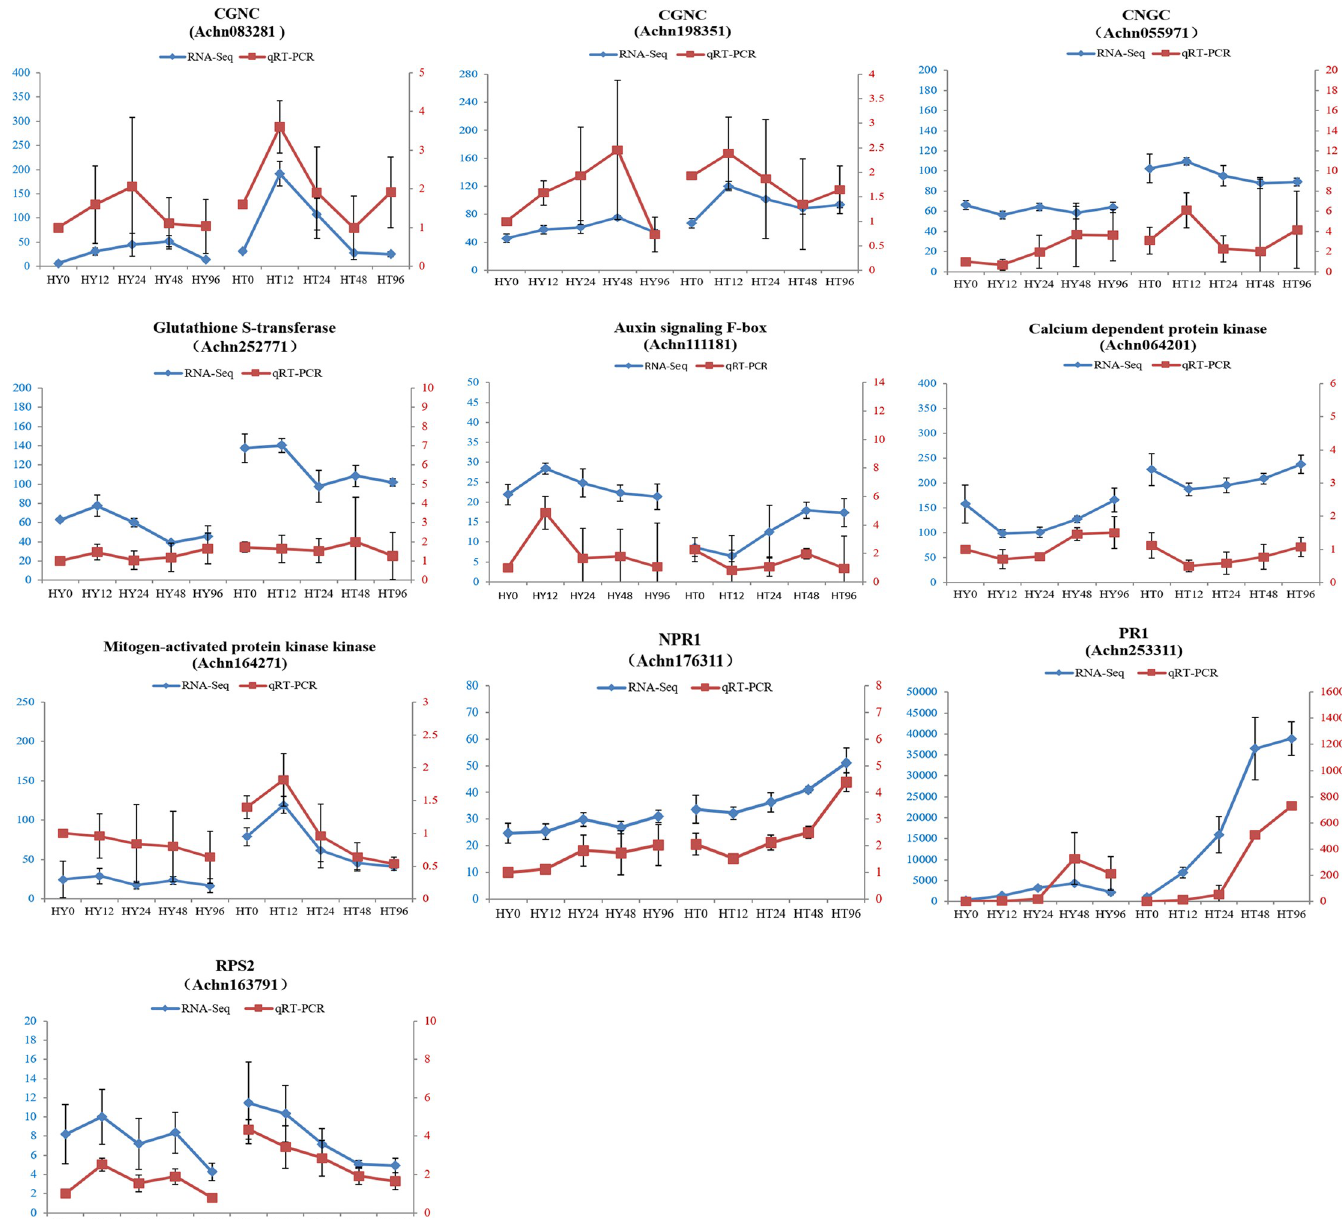
Fig 9. Relative expression levels of ten selected genes at 0, 12, 24,48, and 96hai with Psa in Huate (HT) and Hongyang (HY) measured using qRT-PCR. Left ordinate (in blue) represents the FPKM (expected number of fragments per kilobase of transcript sequence per millions of base pairs sequenced) of RNA-Seq. Right ordinate (in red) represents the relative expression level of qRT-PCR. The abscissa represents 0, 12, 24, 48, and 96 hai (from left to right) with Psa in HY and HT.